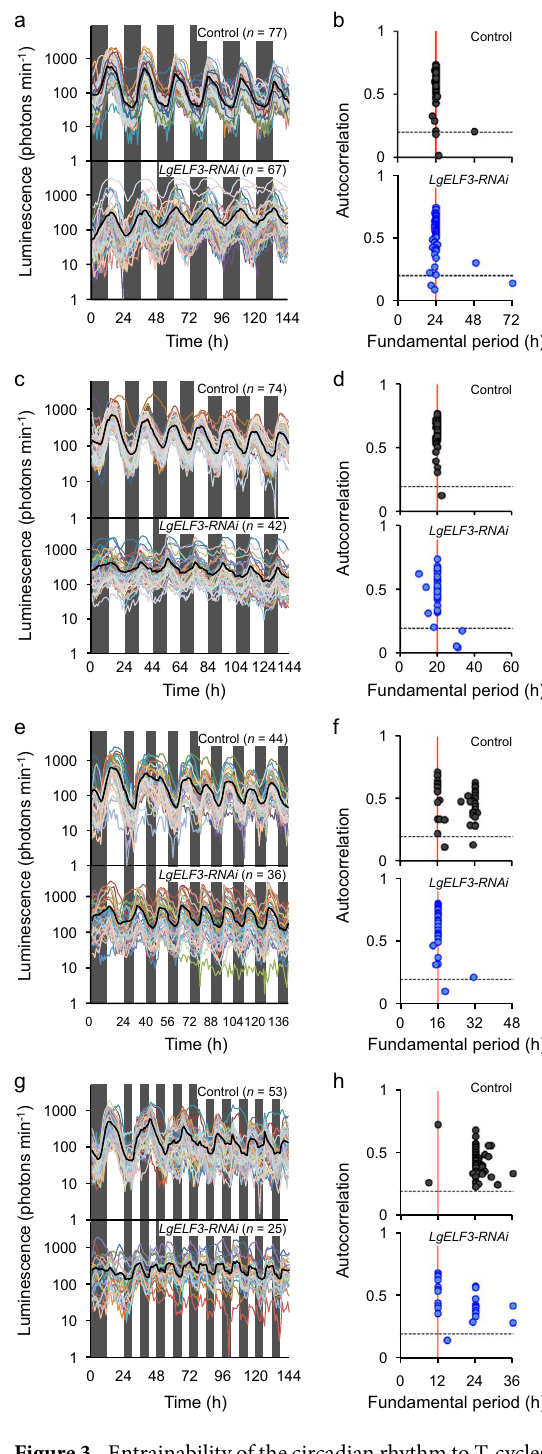
Figure 3. Entrainability of the circadian rhythm to T-cycles in individual cells and its alteration by the LgELF3 knockdown. ( a,c,e,g ) Bioluminescence traces of the AtCCA1::LUC reporter obtained by the single- cell bioluminescence monitoring under various T-cycles, T = 24 h ( a ), 20 h ( c ), 16 h ( e ) and 12 h ( g ), for every measured cell on a frond. A black line in each graph represents the average bioluminescence of the total traces. Shaded boxes indicate the duration of the dark periods in the light-dark cycles. Three experiments were conducted for each condition, except for the T = 24 h condition that had data from two experiments, and a representative trace for each condition is shown. ( b,d,f,h ) Comparison of the fundamental periods of individual bioluminescence traces in T-cycle conditions. The highest peak value of the autocorrelation function of each bioluminescence trace (from 48 h to 144 h) in the graph on the left is plotted against the time lag (fundamental period). The horizontal dashed black lines and the vertical red lines in each graph represent the borders of the 95% confidence intervals of the autocorrelation function and the period lengths of the T-cycles,